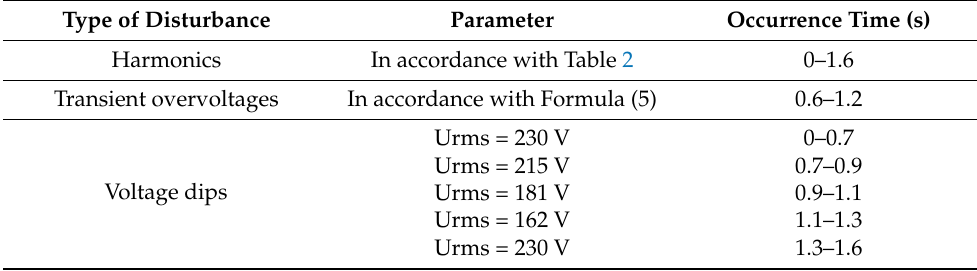
Table 5. Multicomponent disturbance